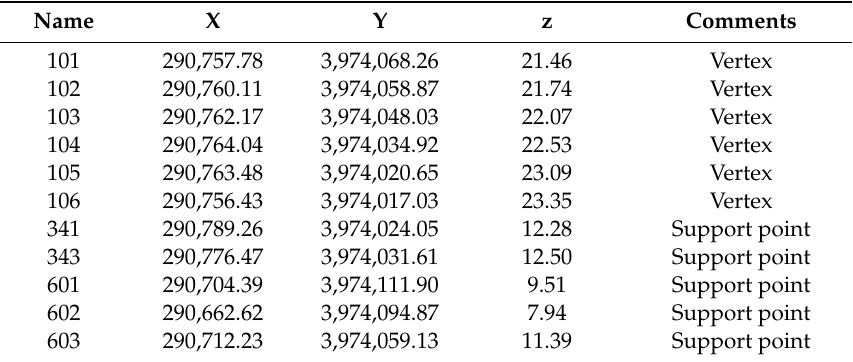
Figure 5. Micro-geodetic network and support points. Table 1. Coordinates of the micro-geodetic network vertices and the support points.